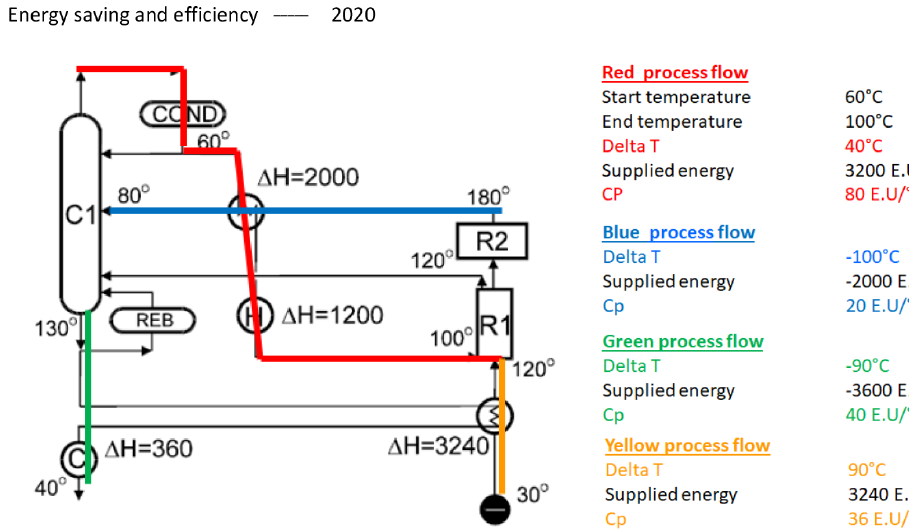
Fig. 26. – Flow-sheet of basic processes, indicating the mass and energy balance